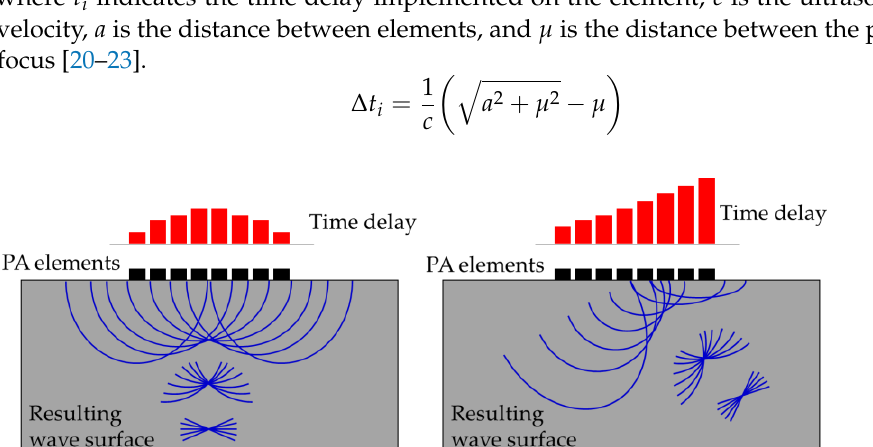
Figure 3. Beam steering according to time delay in PAUT.